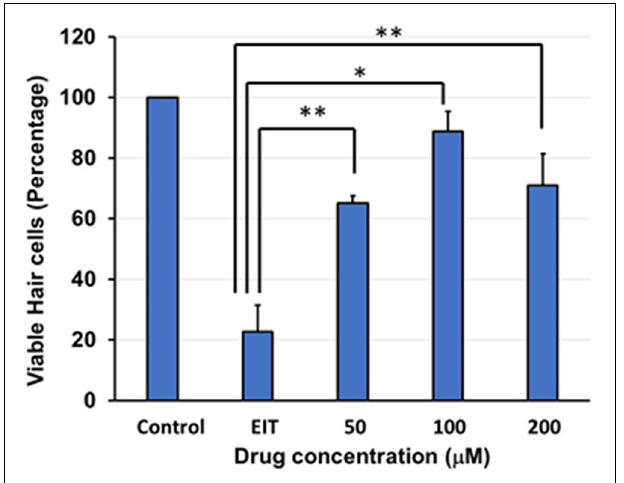
FIGURE 2 | Quantification of HCs. Based on FITC-phalloidin staining, total HCs (outer and inner HCs) were counted and graphed. There was a decrease in total HC count in the OC explants subjected to EIT compared to the control group. TDCA was able to significantly prevent EIT induced sensory cell loss. Data are expressed as mean values ± standard deviation (SD) and are representative of three independent experiments. ∗∗ P < 0.01 or ∗ P < 0.001 compared to the EIT group. n = 6 OCs per group.